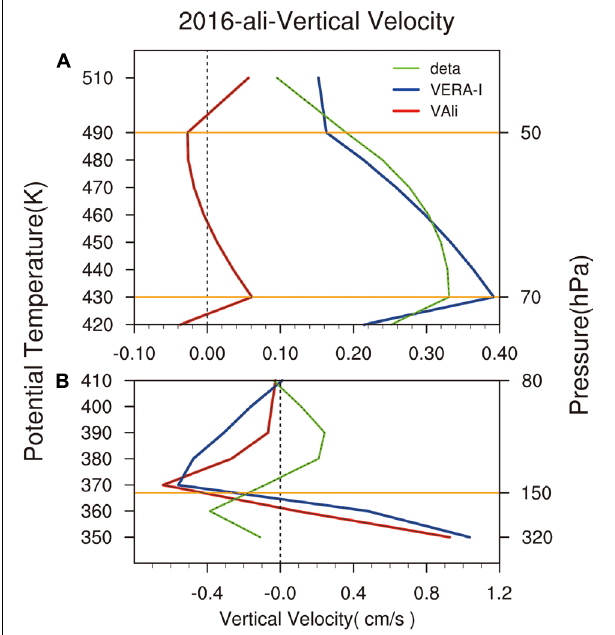
FIGURE 1 | Vertical velocity profile at Ali station. The red line is V Ali , the blue line is V ERA − I , and the green line is the difference between the two. The three yellow lines represent levels of 50, 70, and 150 hPa. (A) and (B) had the different range of